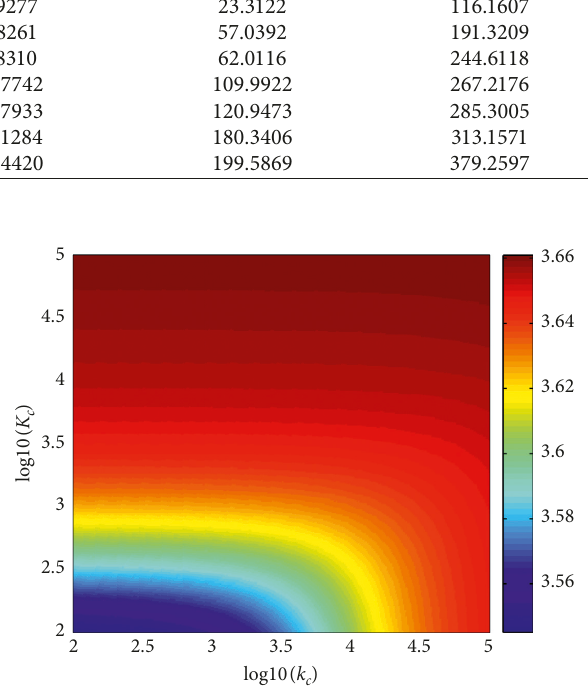
Figure 2: The influence of the coupling translational spring k rotational spring K c to the nondimensional fundamental fre- quencies for the nonuniform double-beam system with c r (cid:31)